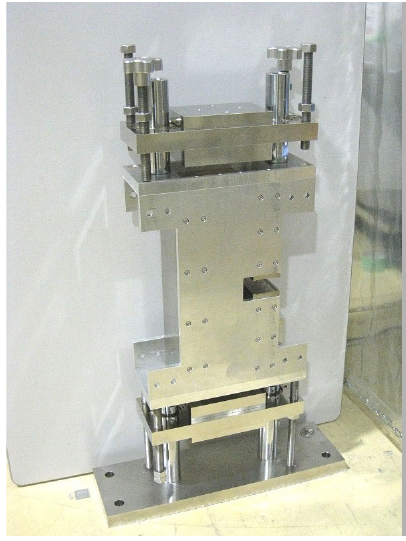
Fig. 2. The cross sectional view of the magnet is essentially that shown schematically in Fig. 1. The magnet consists of Neodynium-Iron-Boron (NdFeB) magnet (NMX-33UH,